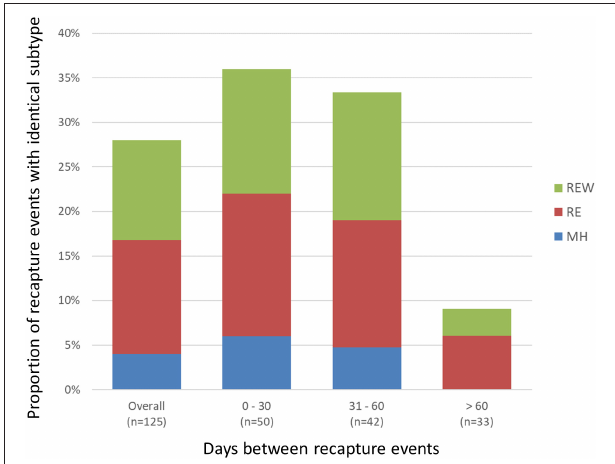
FIGURE 3 | Short- vs. long-term colonization with Campylobacter in a raccoon population on conservation and swine farm sites in southwest Ontario, Canada. Analysis of consecutive Campylobacter positive recapture events yielding an identical subtype indicates that as the duration between captures increased beyond 60 days, there is a large decrease in the number of cases where the same subtype was observed, suggesting that most animals are only transiently colonized. Among the small proportion of recapture events consistent with prolonged colonization (i.e., consecutive and temporally separated Campylobacter- positive recapture events yielding the same subtype), results indicate that these are more likely to involve raccoon-adapted subtypes from RE and REW